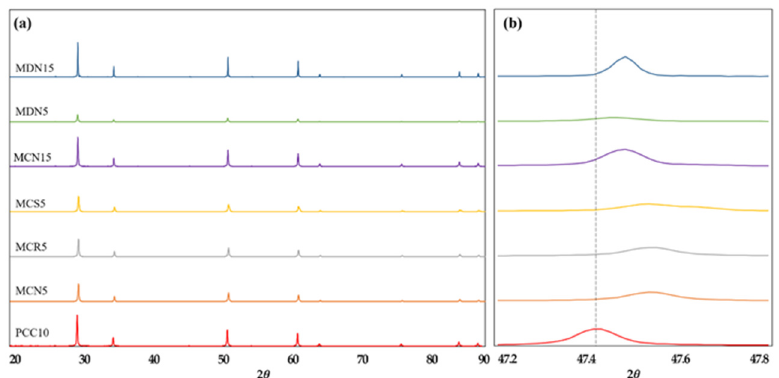
Figure 4. XRD pattern of all prepared foam devices: ( a ) XRD pattern for the range of (2 θ = 20–90 ◦ ) and ( b ) expanded range of (2 θ = 47.2–47.8 ◦ ) which showing the peak shift toward higher diffraction angle by the incorporation of Mn into CeO 2 .